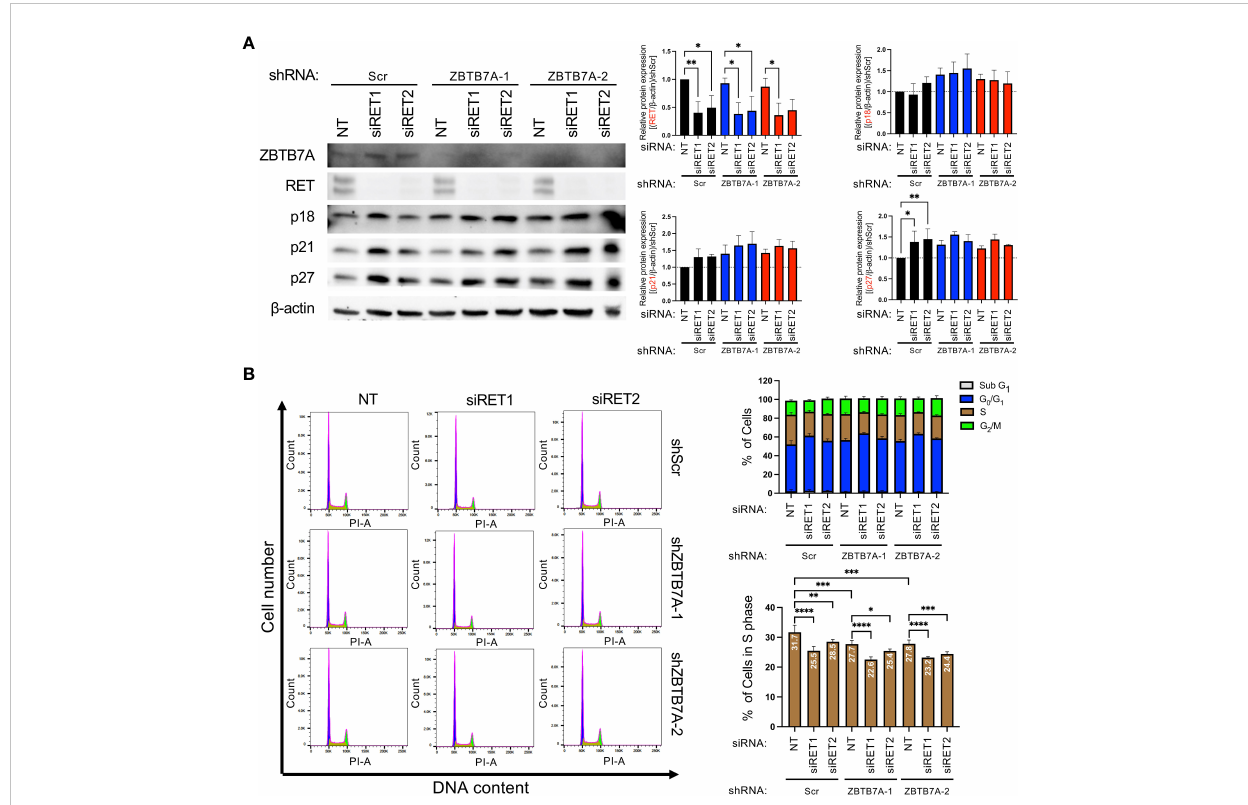
FIGURE 4 Silencing RET in NCI-H660 ZBTB7A knockdown cells further reduced cell entry into S phase. (A) Protein expression of ZBTB7A, RET and CDK negative regulators in NCI-H660 shScr and ZBTB7A knockdown cells after transient transfection with non-targeting (NT) or two unique anti-